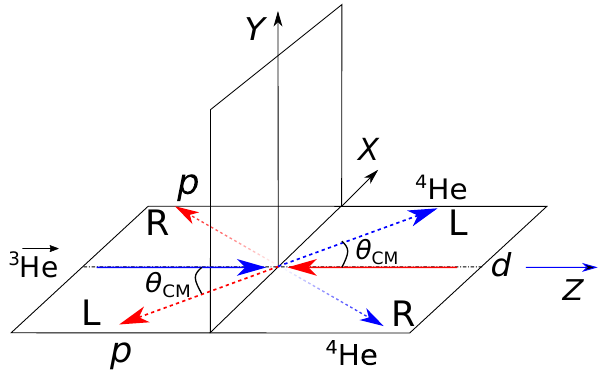
Figure 1. Coordinate system for the analyzing power in the CM frame. The direction of the 3 He polarization vector is along the Y axis. In the XZ scattering plane, the definition of the left and right sides for protons at a polar angle θ CM is with respect to the deuteron beam. The left and right sides for 4 He particles is from the view of the 3 He